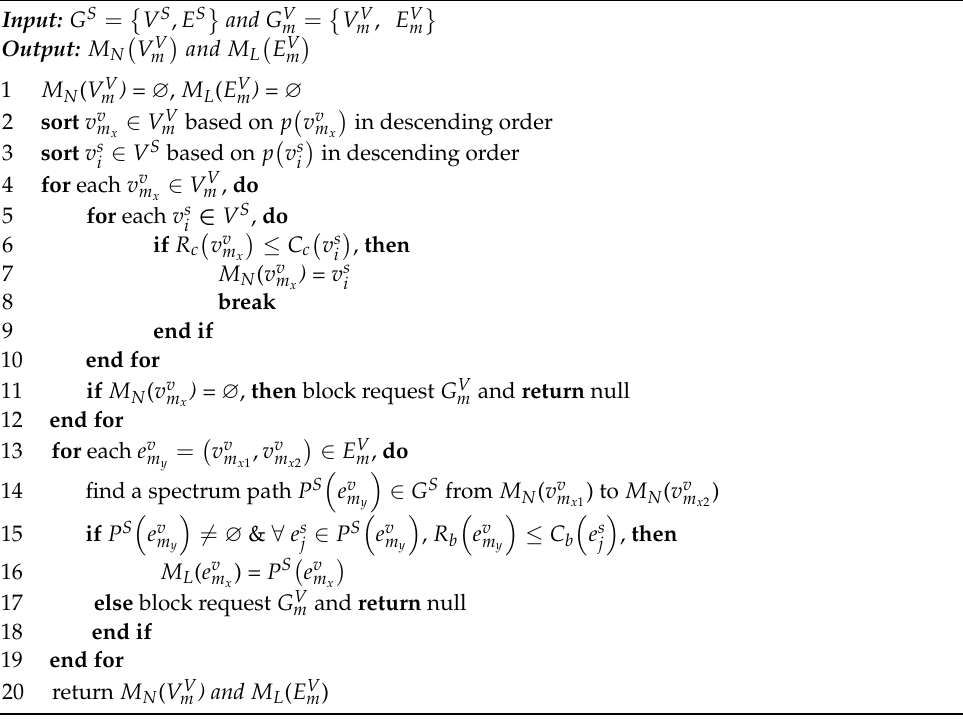
Algorithm 2 Flexible-Grid Unaware-Virtual Network Embedding Algorithm